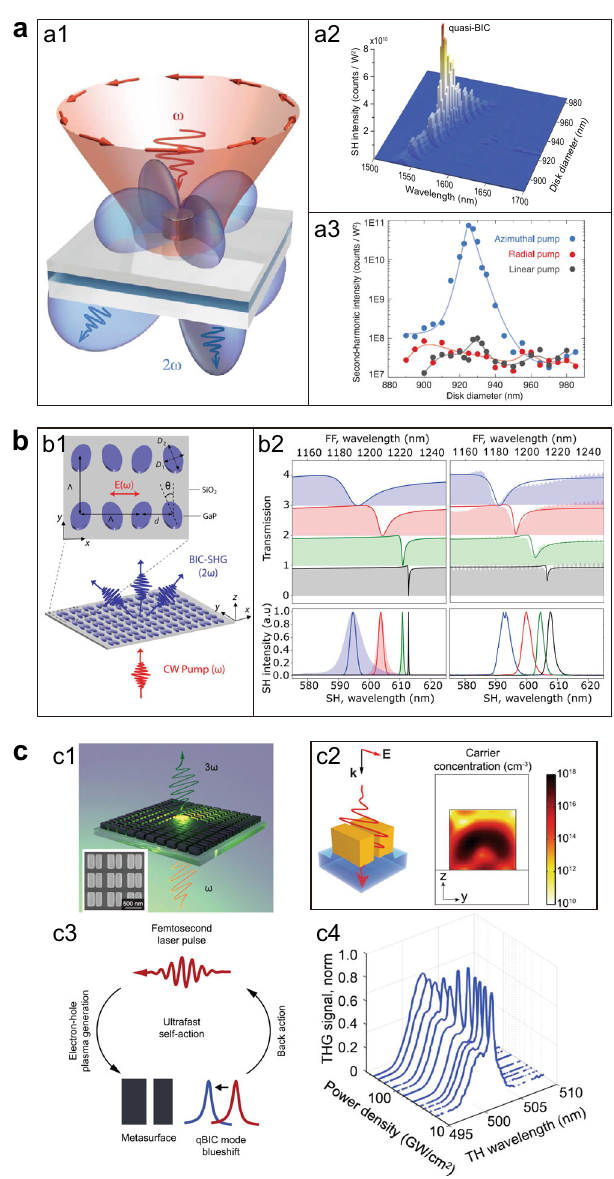
Fig. 5 BICs for enhanced nonlinearities. a Second-harmonic generation (SHG) using quasi-BICs. Schematic of the SHG in the AlGaAs nanodisk under azimuthally polarized beam excitation (a1). 3D map of second- harmonic intensity measured as a function of the pump wavelength and nanodisk diameter for an azimuthally polarized incident beam (a2). Measured second-harmonic intensity as a function of the nanodisk diameter at a 1570 nm pump wavelength for different pump polarizations (a3). Reprinted by permission from ref. 22 , copyright 2020. b Nonlinear process in dielectric metasurfaces. Schematic of a metasurface comprising square-lattice dimers formed by two elliptical cylinders with a relative tilt of θ between their major axes (b1). Simulated (left) and measured (right) transmission spectra near the quasi-BIC resonance (upper) and SHG spectra (lower) with varying values for θ , from 30° to 5° (b2). Reprinted by permission from ref. 51 , copyright 2020. c Si metasurface for third-harmonic generation (THG). THG from the quasi-BIC metasurface (c1), distribution of the carrier concentration in the metasurface unit cell (c2), scheme of the ultrafast self-action effect (c3), and THG spectra on the pump power (c4). Reprinted by permission from ref. 57 , copyright